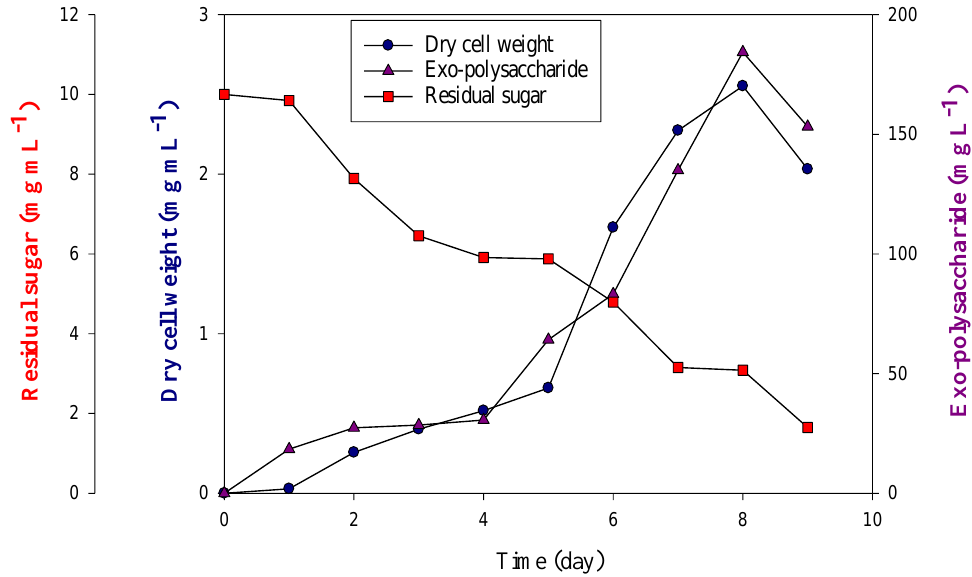
Figure 4. The effect of Tween 80 at 0.6 g/L on mycelia growth and EPS production in a 5 − L stirred tank bioreactor. Table 1. Fermentation parameters of the batch experiments in a 5 L and a 20 L stirred tank bioreactor under different culture conditions.